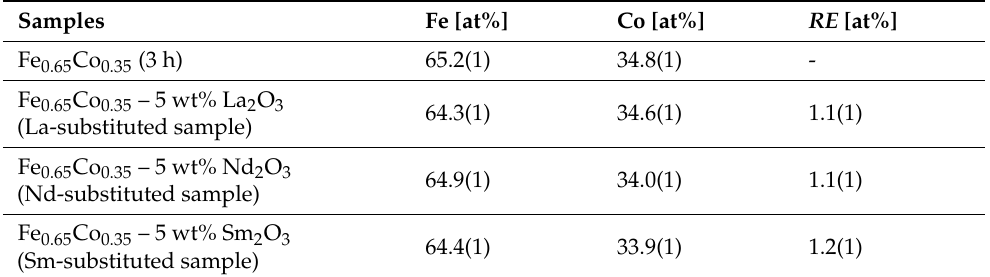
Table 1. Results of X-ray microprobe analysis (EDS) recorded for the obtained powders. Samples